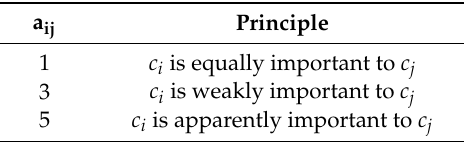
Table 2. The principle of judgment matrix